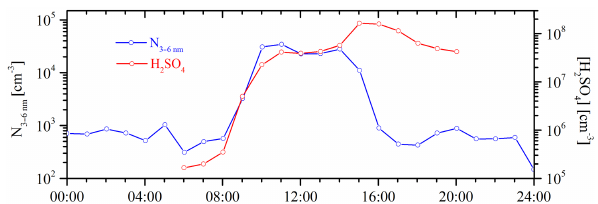
Figure 3. The particle number concentration of 3–6nm ( N 3 − 6 , blue) and sulfuric acid proxy concentration ([H 2 SO 4 ], red) on 14 October 2014 fit a good relationship ( R 2 = 0.975) between 06:00 and 14:00LT during the NPF